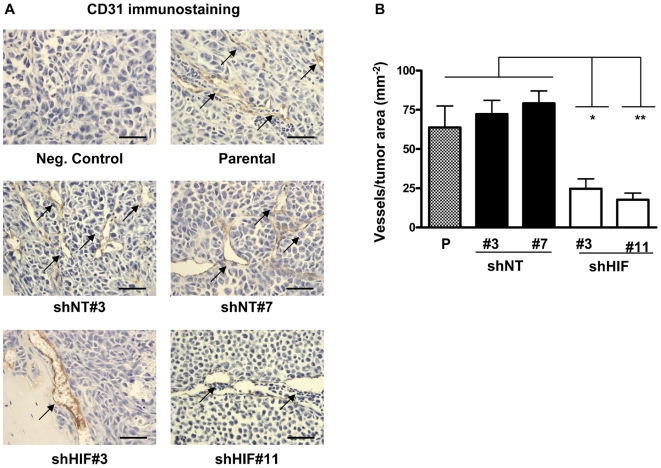
HIF-1α knockdown decreases tumor angiogenesis at sites of bone metastases in mice.(A) Representative sections from mice with bone metastases stained for the endothelial cell marker CD31. Arrows indicate CD31+ vessels. Scale bar equals 50 µm (B) The number of vessels in bone metastases was counted in three non-overlapping fields at 200×magnification per mouse (n = 3 per group). Results are expressed as the mean ± SEM number of vessel per tumor area. * P<0.05, ** P<0.01, **** P<0.001, using a one-way ANOVA with a Newman-Keuls multiple comparison test.